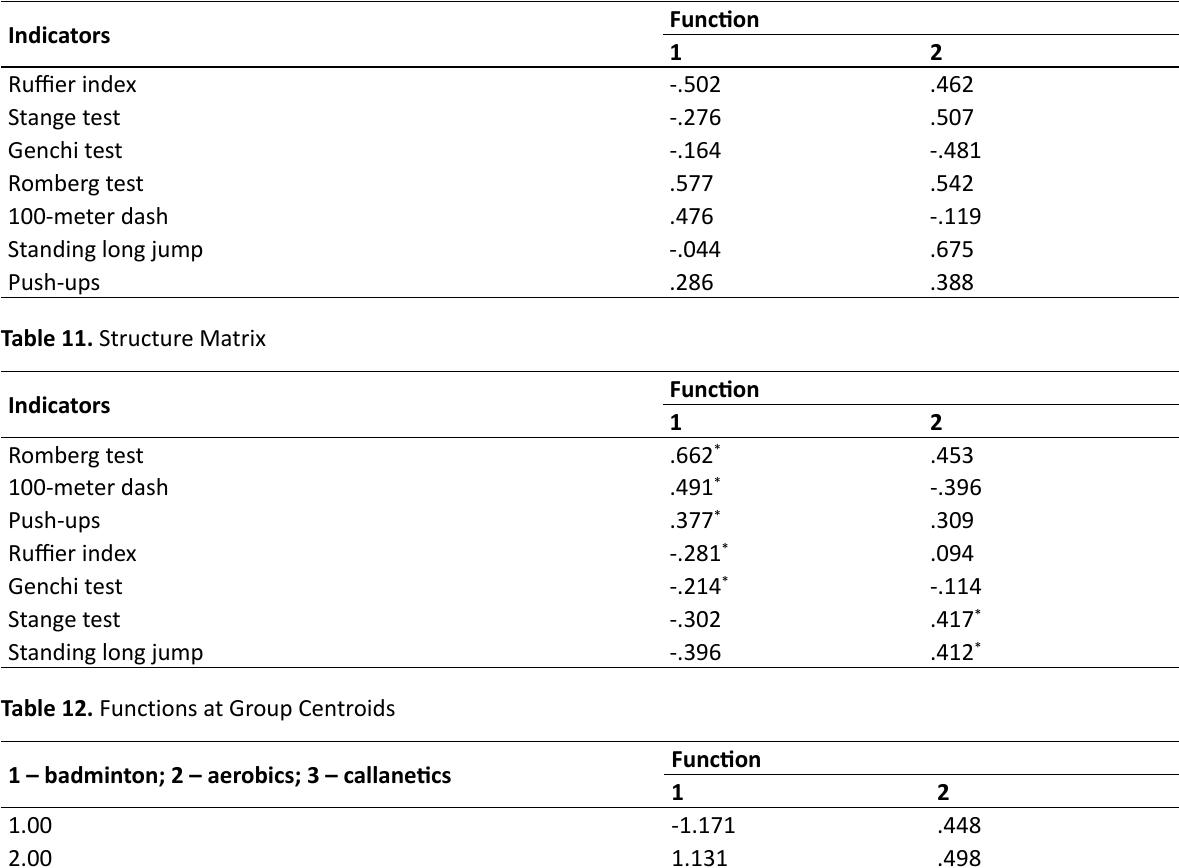
Table 10. Standardized Canonical Discriminant Function Coefficients